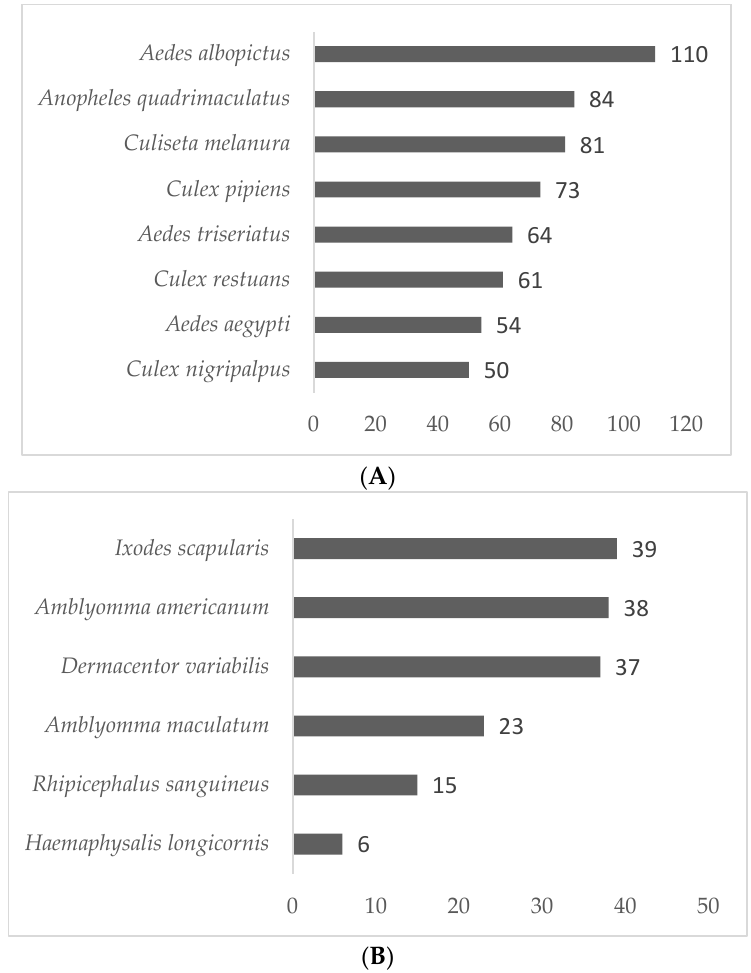
Figure 1. Reported mosquito and tick species found during surveillance efforts ( n = 150 agencies). ( A ) Number of organizations reporting mosquito species in their region. ( B ) Number of organizations reporting tick species in their